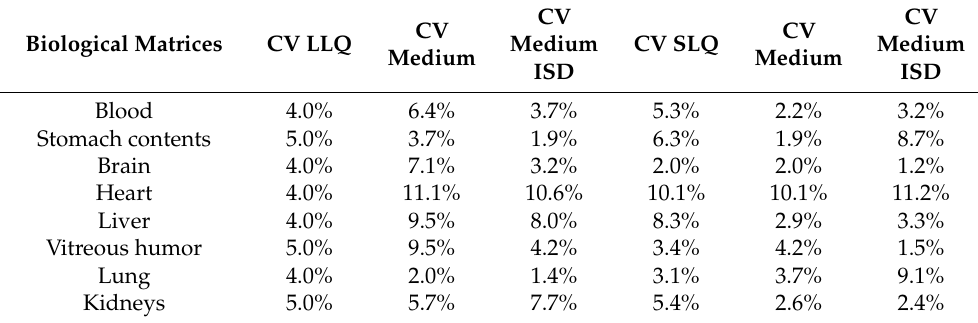
Table 18. Coefficient of variation (CV) of the lower limit of quantification (LLQ) and the superior limit of quantification (SLQ), as well as the average CV (average of the CV of the other points of the calibration curve), and of the internal standard (ISD) in the different matrices, expressed in percentage of